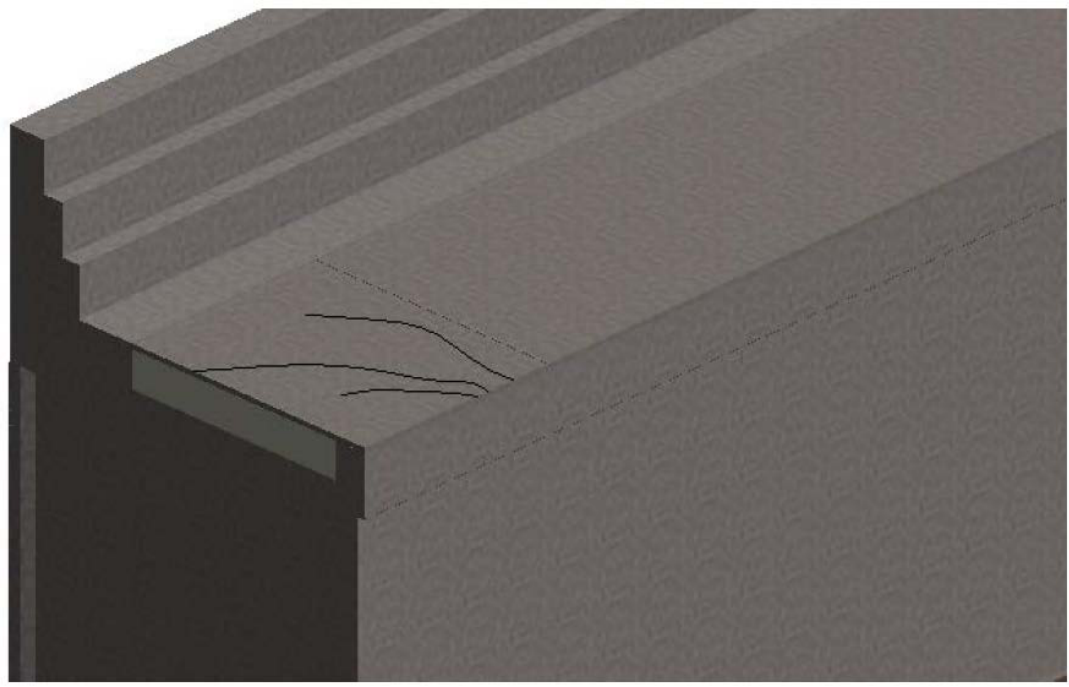
Figure 10. Cracking of the spur breakwater slab.